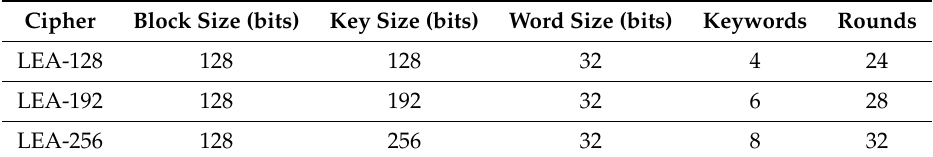
Table 4. Parameters of